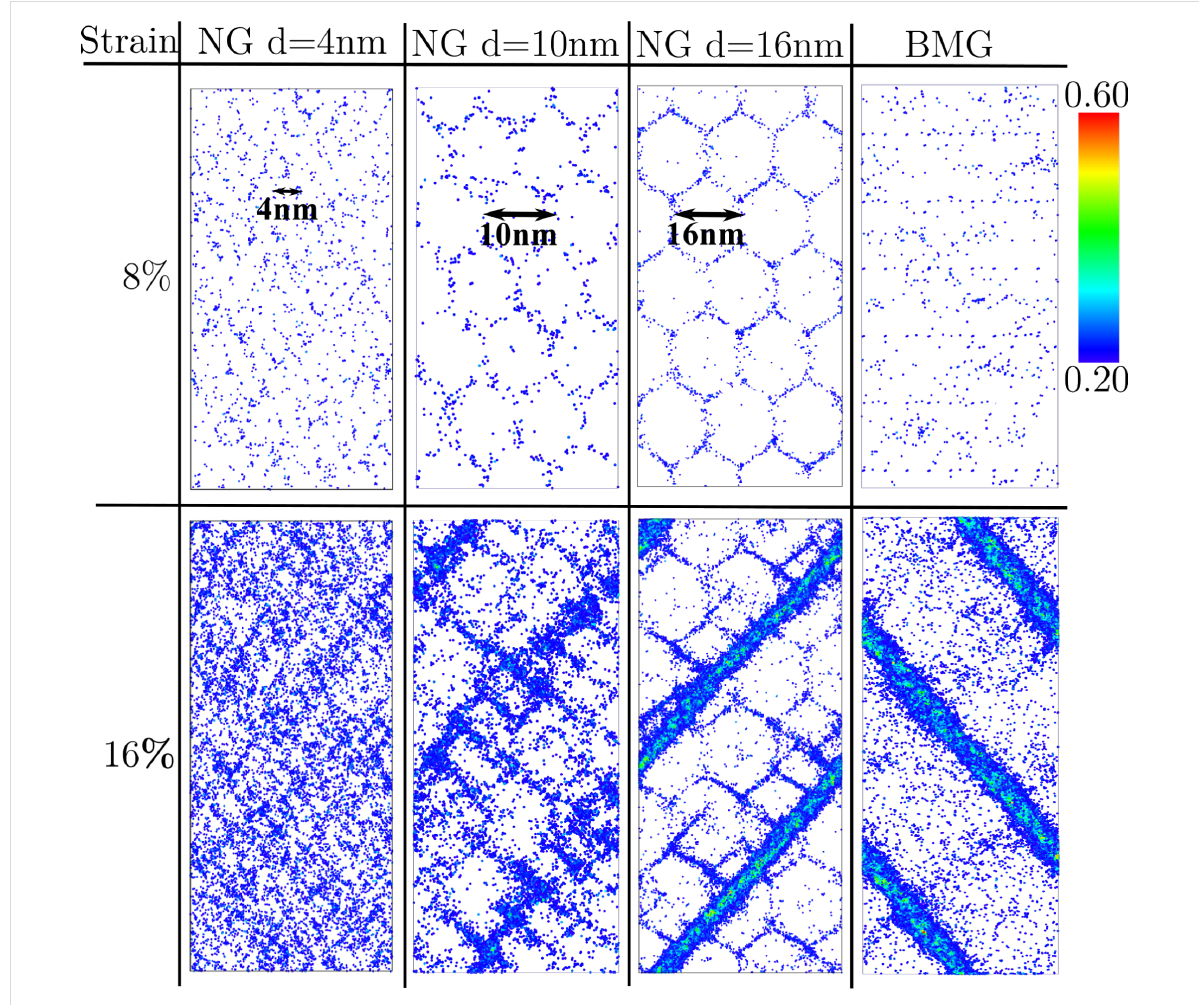
Figure 2: Local atomic shear strain for Cu 64 Zr 36 BMG and NGs with grain sizes of 4 nm, 10 nm and 16 nm, respectively.